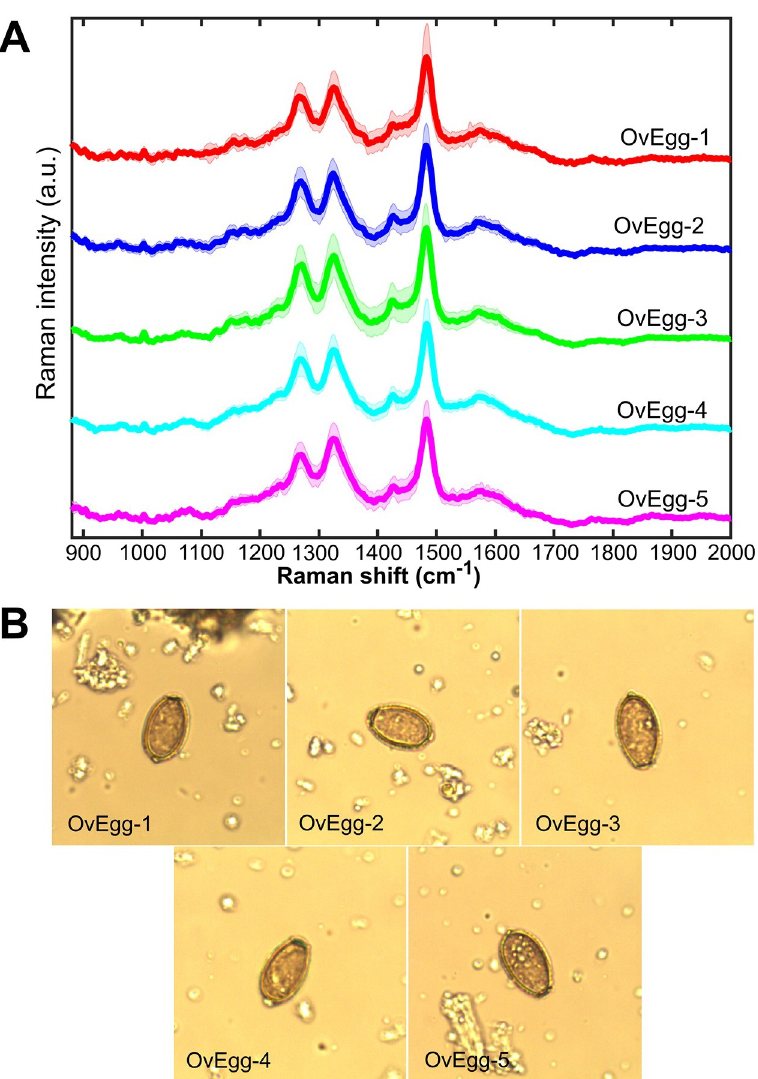
Fig 2. Averaged Raman spectra of O . viverrini eggs from the feces of each infected hamster. The averaged Raman spectra are shown (A) along with a representative microscope image of an O . viverrini egg from each infected hamster taken with a Raman integrated white-light imaging camera (B). The solid lines and shaded areas represent means and standard deviations of the measurements (n = 10), respectively.